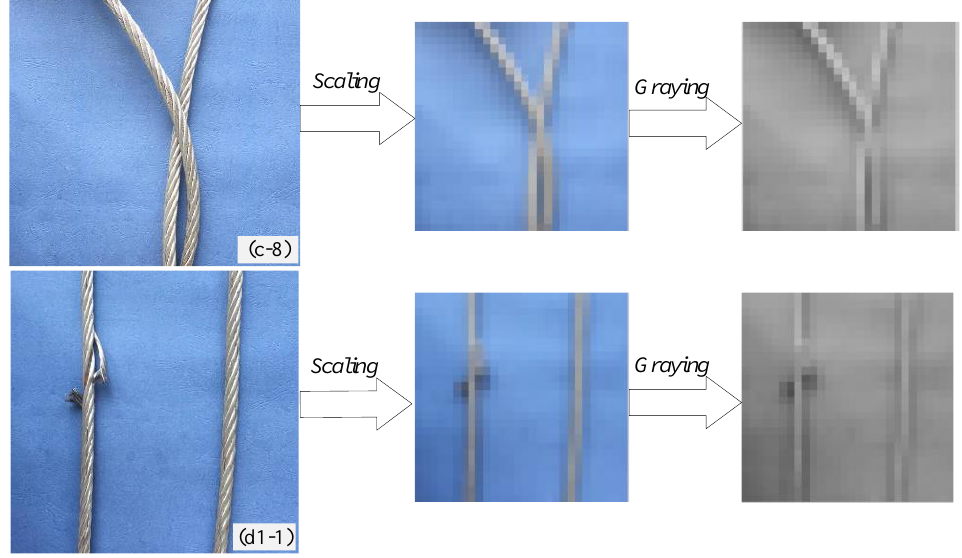
Figure 7. The scaling and grayscale images. Table 3. The nine kinds of tail rope states.